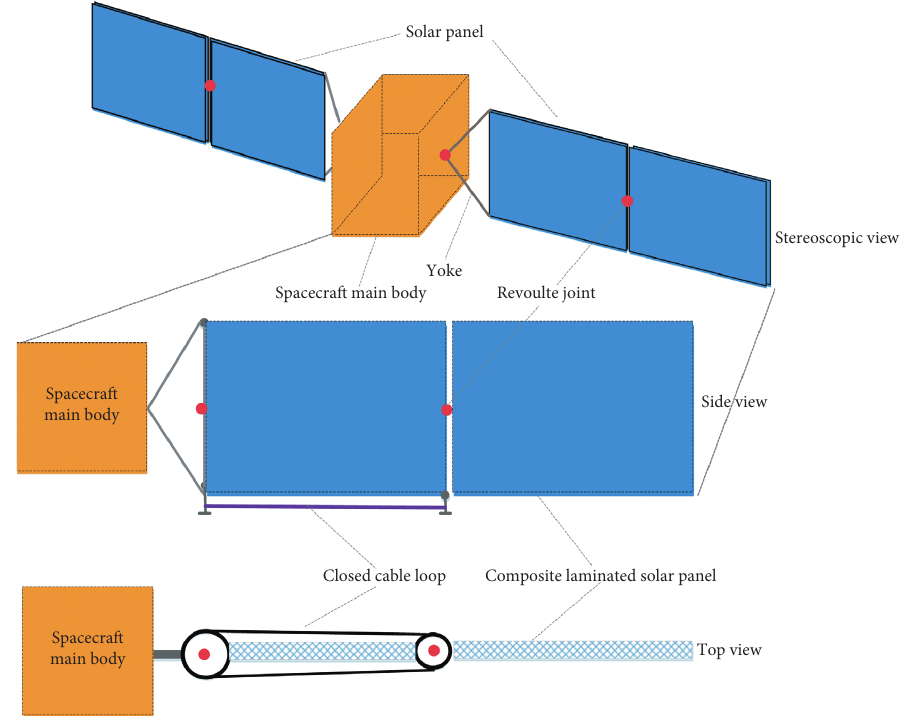
Figure 1: Scheme diagram of the spacecraft